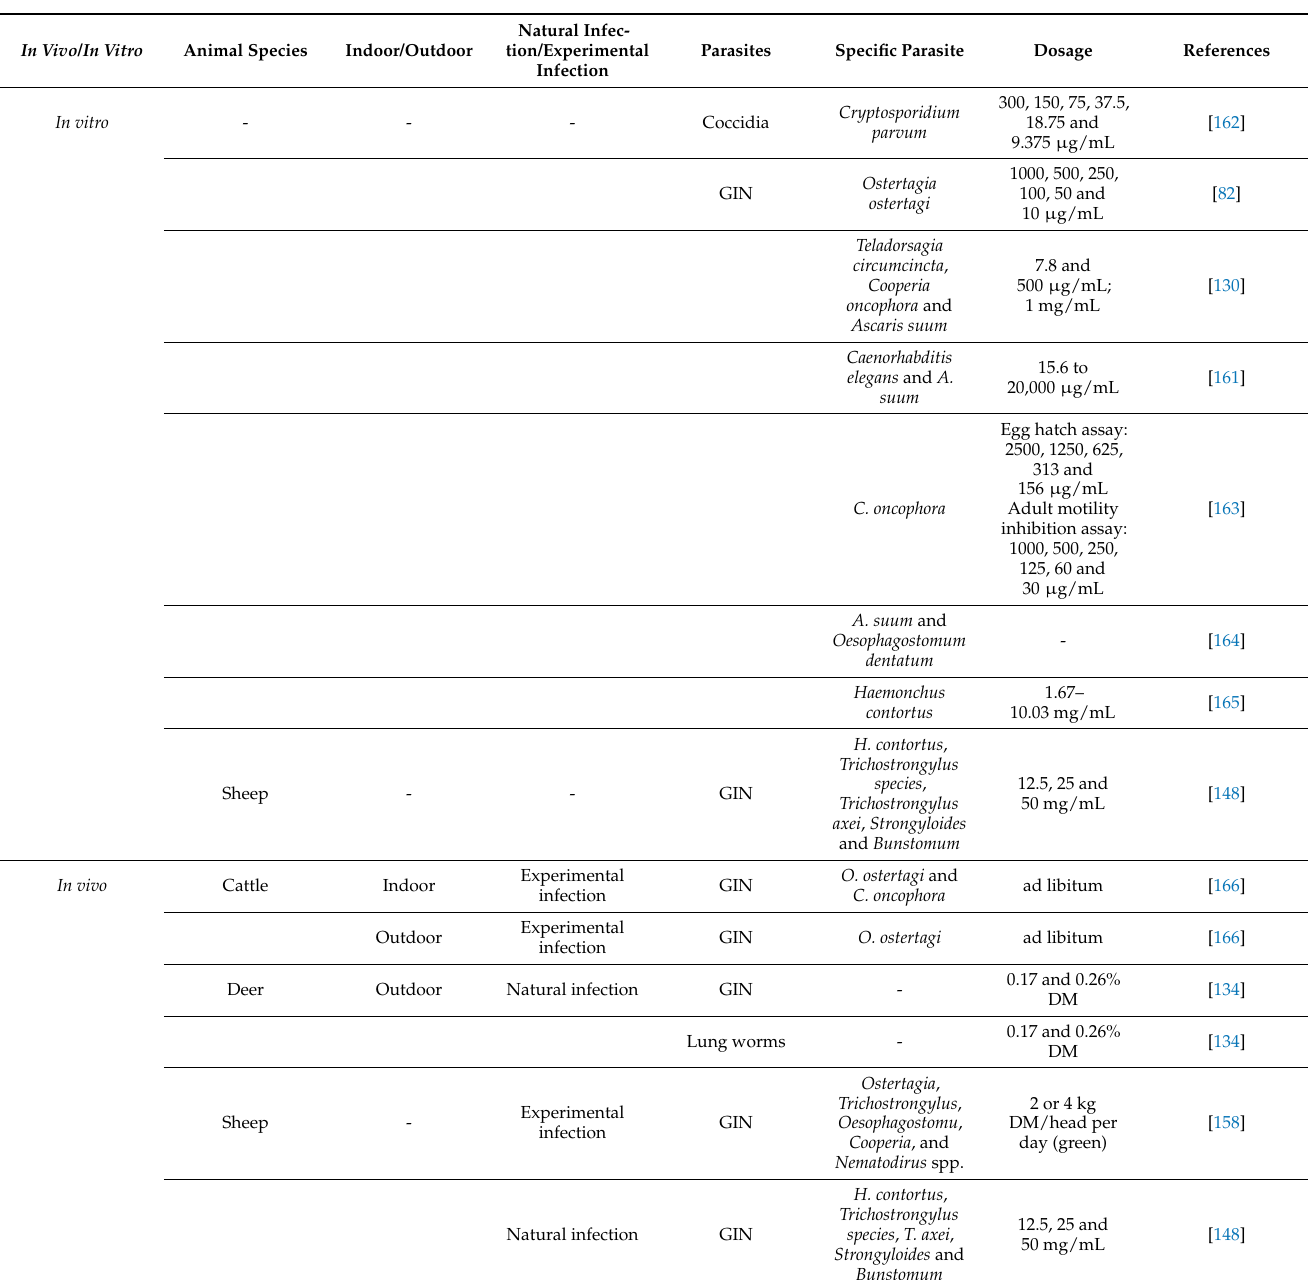
Table 2. Brief description of trials for the antiparasitic plant: Cichorium intybus